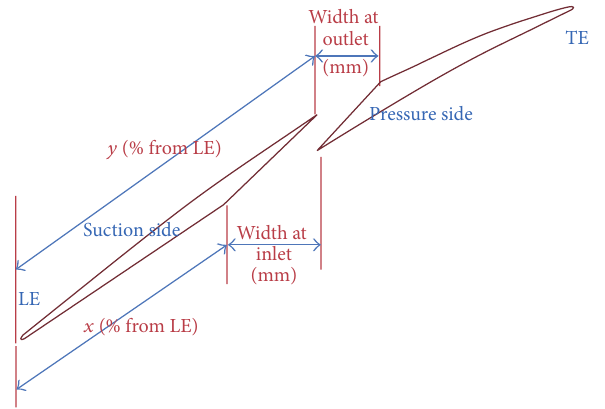
Figure 5: A section of rotor blade passing through aspiration slot.